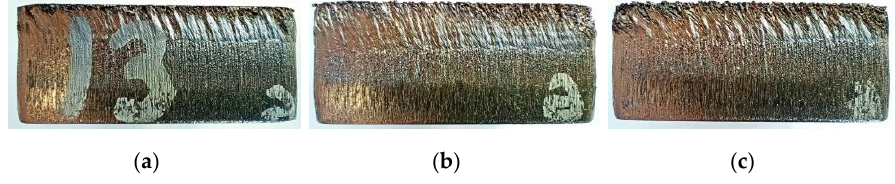
Figure 5. Surface views: ( a ) Sample 13, ( b ) Sample 15, and ( c ) Sample